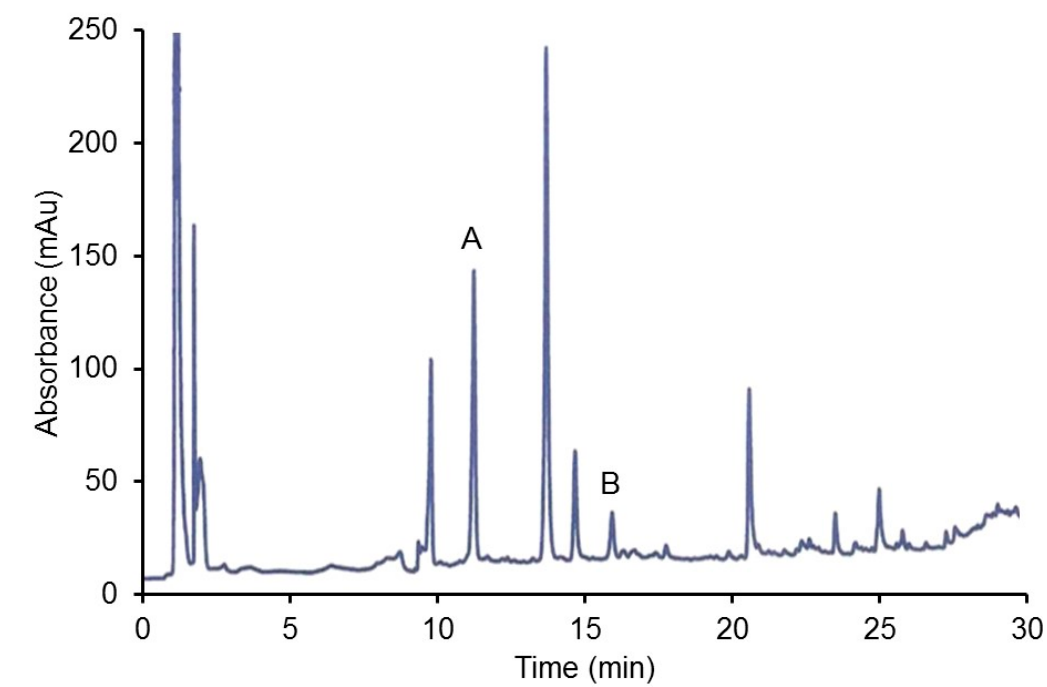
Foods 2019 , 8 , x FOR PEER REVIEW 6 of 10 Figure 1. HPLC of kidney extract from rat administered quercetin (A = sulfonated quercetin, B = quercetin). Figure 1. HPLC of kidney extract f ro m rat administered quercetin (A = sulfonated quercetin, B = quercetin).